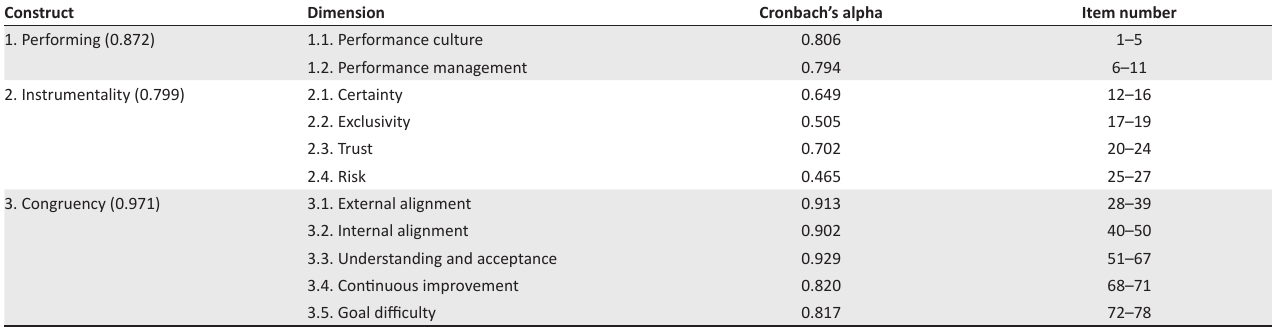
TABLE 1: Relationship between items, dimensions and constructs.